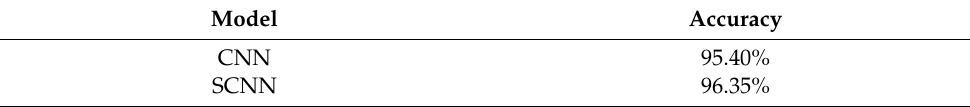
Table 3. The accuracy of the single model.